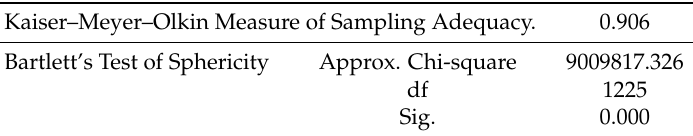
Table 12. KMO and Bartlett’s Test, where Approx. chi-square means the chi-square test; df means the degree of freedom; Sig. means the probability value of the